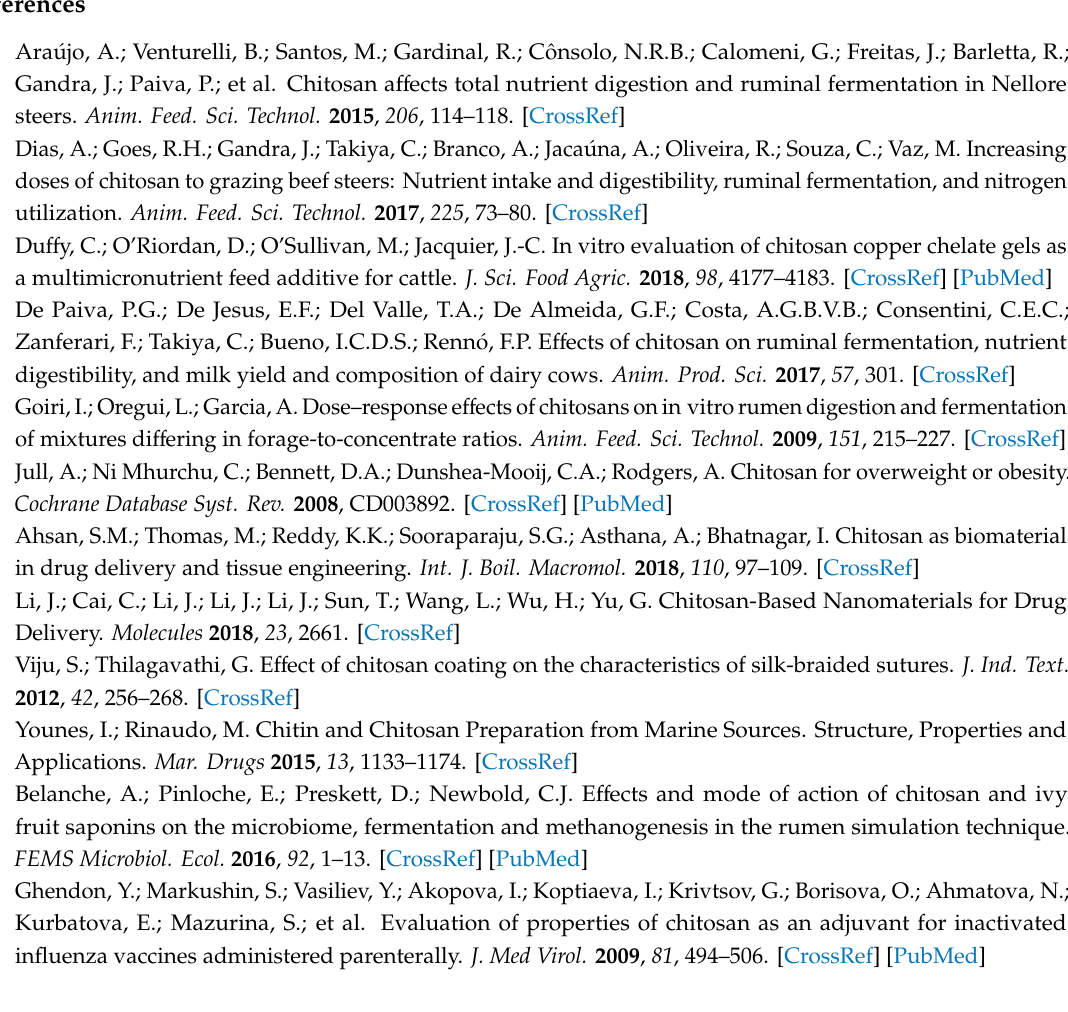
Table S1: Diet and composition of the standard compounds for sheep